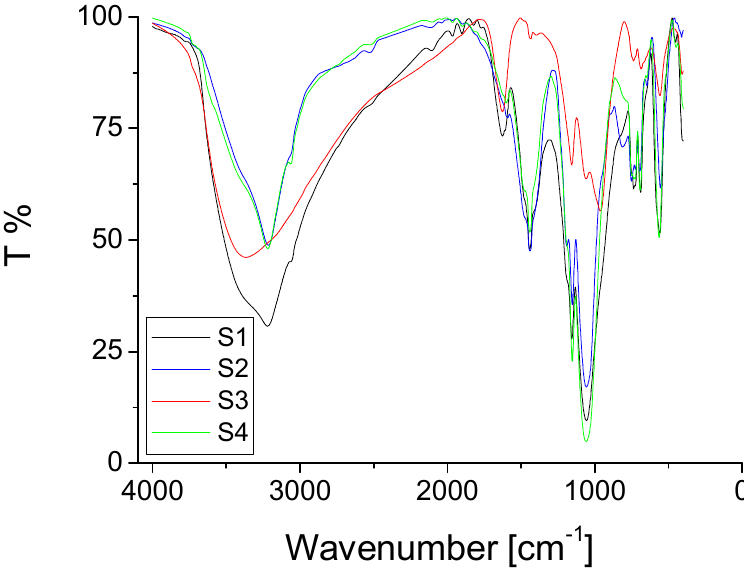
Figure 1. IR results obtained for compounds S1 - S4 .